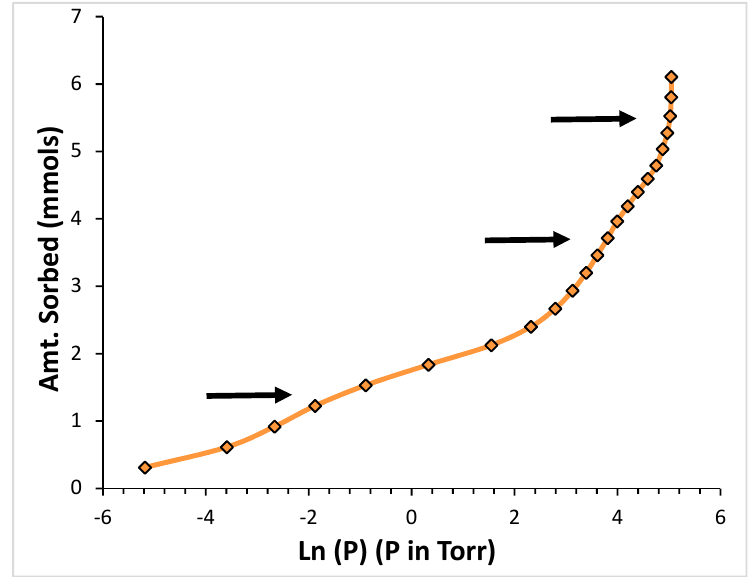
Figure 2. Adsorption isotherm for Ar on the chemically-opened nanohorns at 76.32 K. The arrows indicate (from the lowest to the highest) adsorption on the high energy binding sites, the low energy binding sites, and the saturated vapor pressure. The amount sorbed is in millimoles.